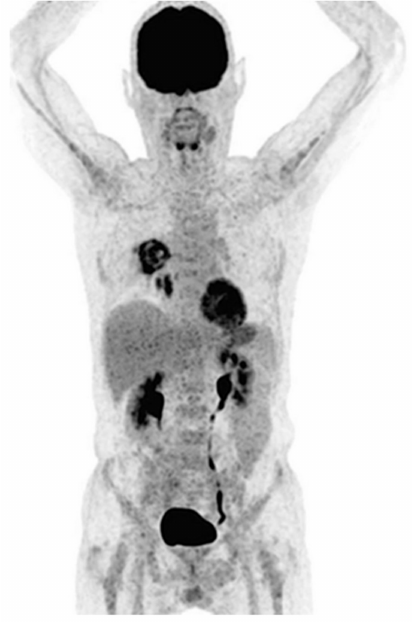
Figure 3. Clinical 18 F-FDG PET imaging of an acute myelogenous leukaemia patient diagnosed with pulmonary aspergillosis. Complex heterogeneous lesions can be seen in the lungs. Patient was diagnosed using BAL. Adapted from Ankrah et al. Eur. J. Nucl. Med. Mol. I 2019, 46 ,